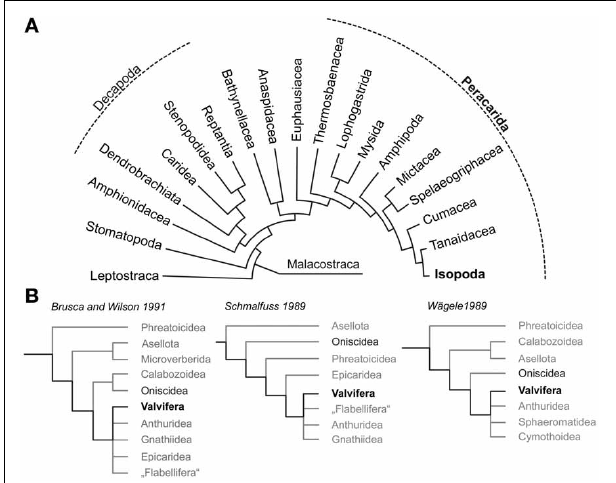
FIGURE 1 | Phylogenetic relationships of Malacostraca and Isopoda. (A) Phylogeny of Malacostraca compiled after Richter and Scholtz (2001) (B) Competing hypotheses on the phylogenetic relationships within Isopoda and unresolved positioning of Valvifera according to Brusca and Wilson (1991), Schmalfuss (1989) and Wägele